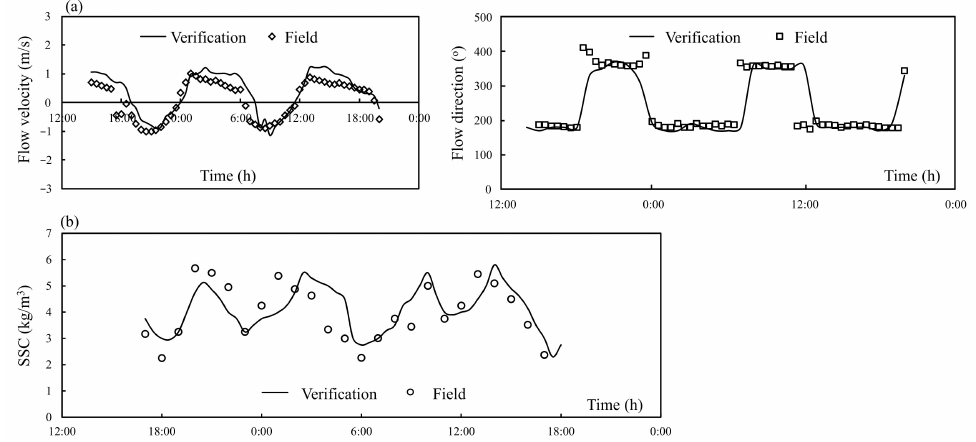
Figure 4. Model verification: ( a ) flow velocity and direction, and ( b ) SSC. The verification points were selected at the proposed tidal-gate position (NRTG in Figure 2a).